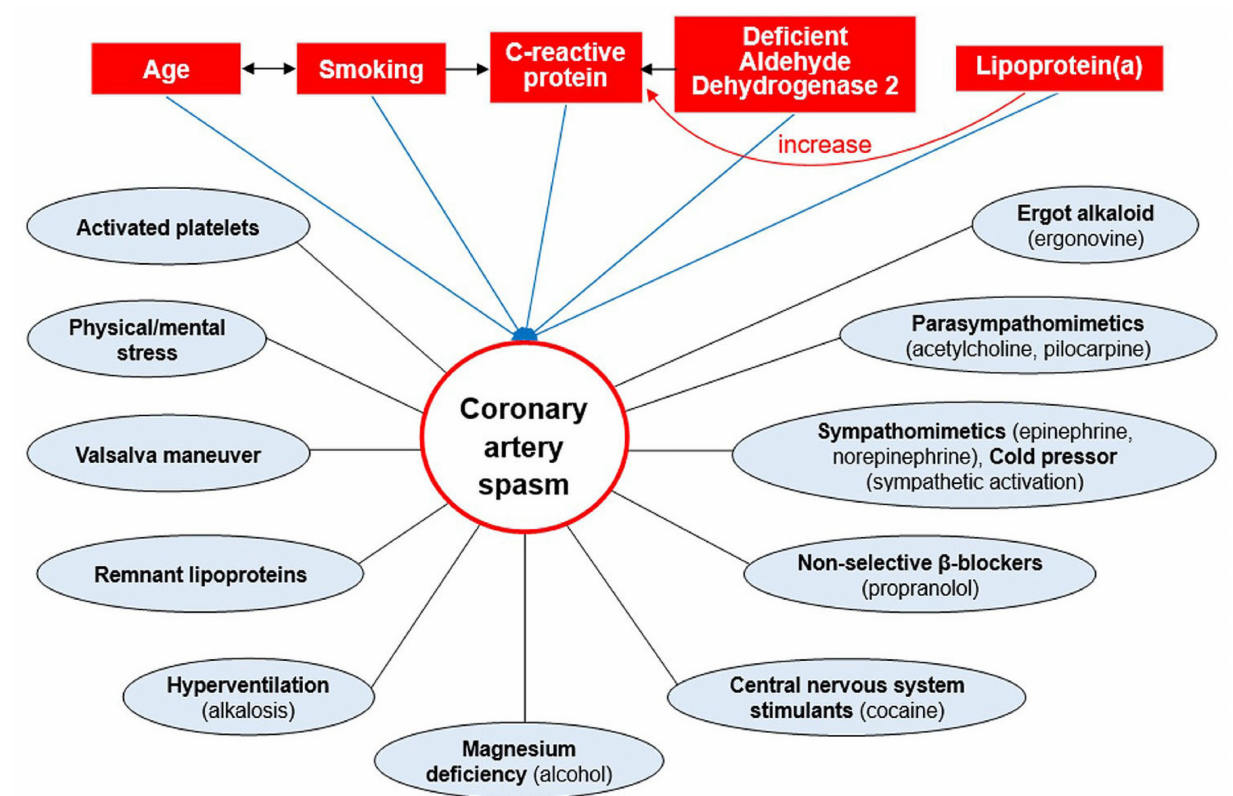
Figure 5. Risk factors and precipitating factors are represented by rectangles and circles, respectively, for CAS. (Adapted from [33], with permission of the